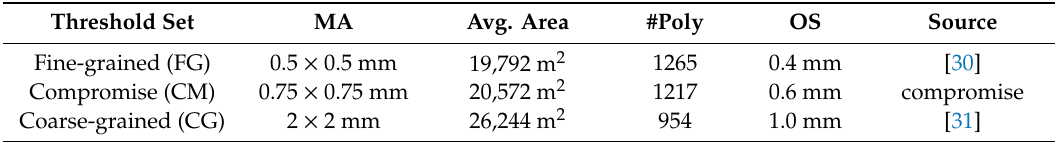
Table 4. Goal value sets for size constraints used in Test Case 2. MA: minimum area; OS: object separation, #poly = number of polygons.